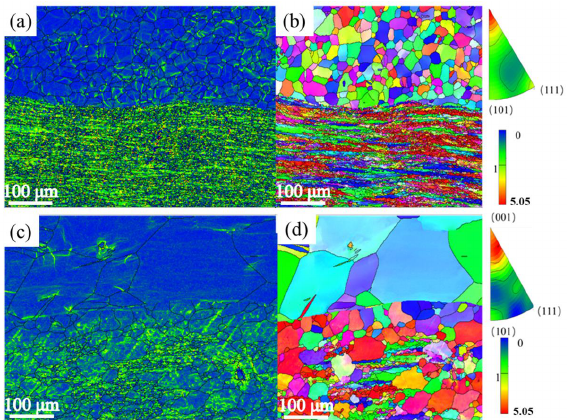
Figure 6. EBSD maps of as-rolled ( a , b ) and ( c , d ) annealing (at 280 °C for 2 h) sample, ( a , c ) are geo- metrically necessary dislocations (GND) distribution maps, ( b , d ) are inverse pole figure (IPF) maps.